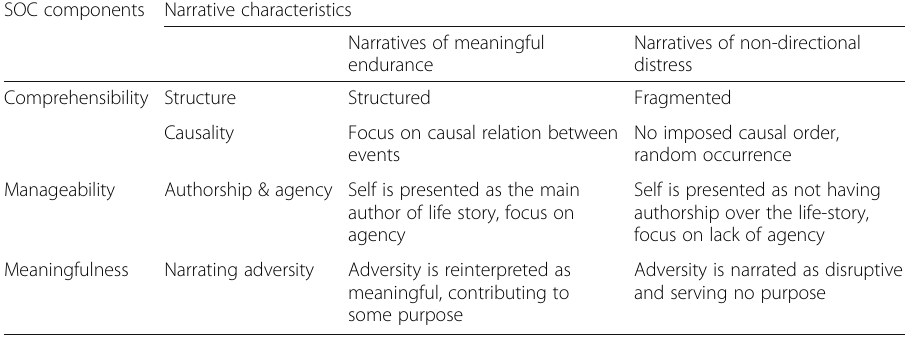
Table 1 Overview characteristics and differences between the Sense of Coherence, narratives of meaningful endurance and narratives of non-directional